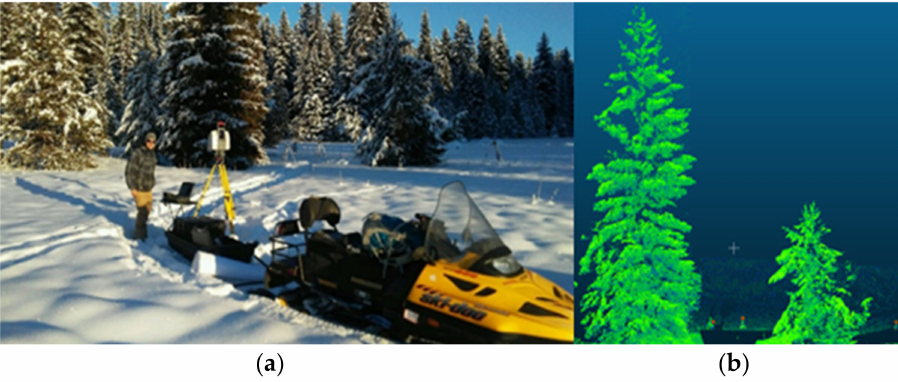
Figure 3. ( a ) Photo of the lead author conducting terrestrial laser scanning (TLS) at Bear Basin on December 5, 2018; ( b ) raw TLS point cloud data of two